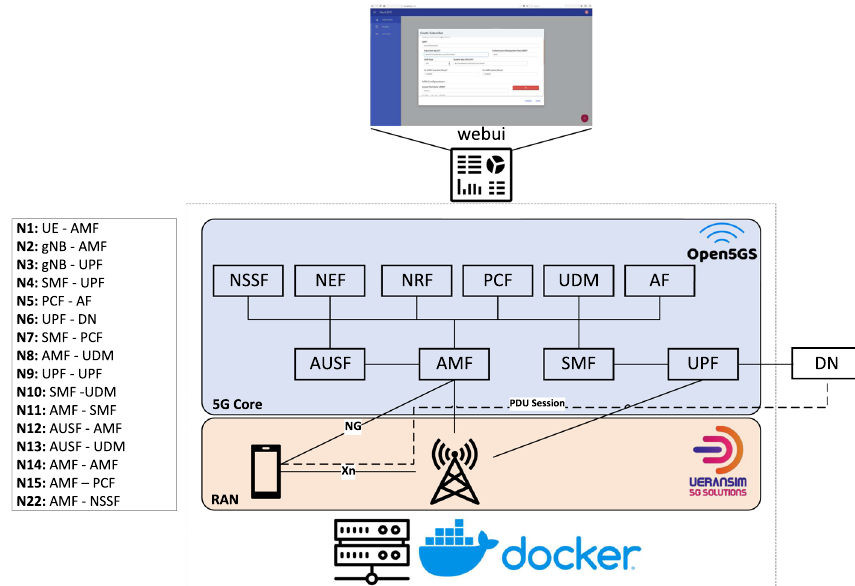
Fig. 1 5G Testbed: Visualization of the containerised 5G testbed used to validate the attacks performed in this